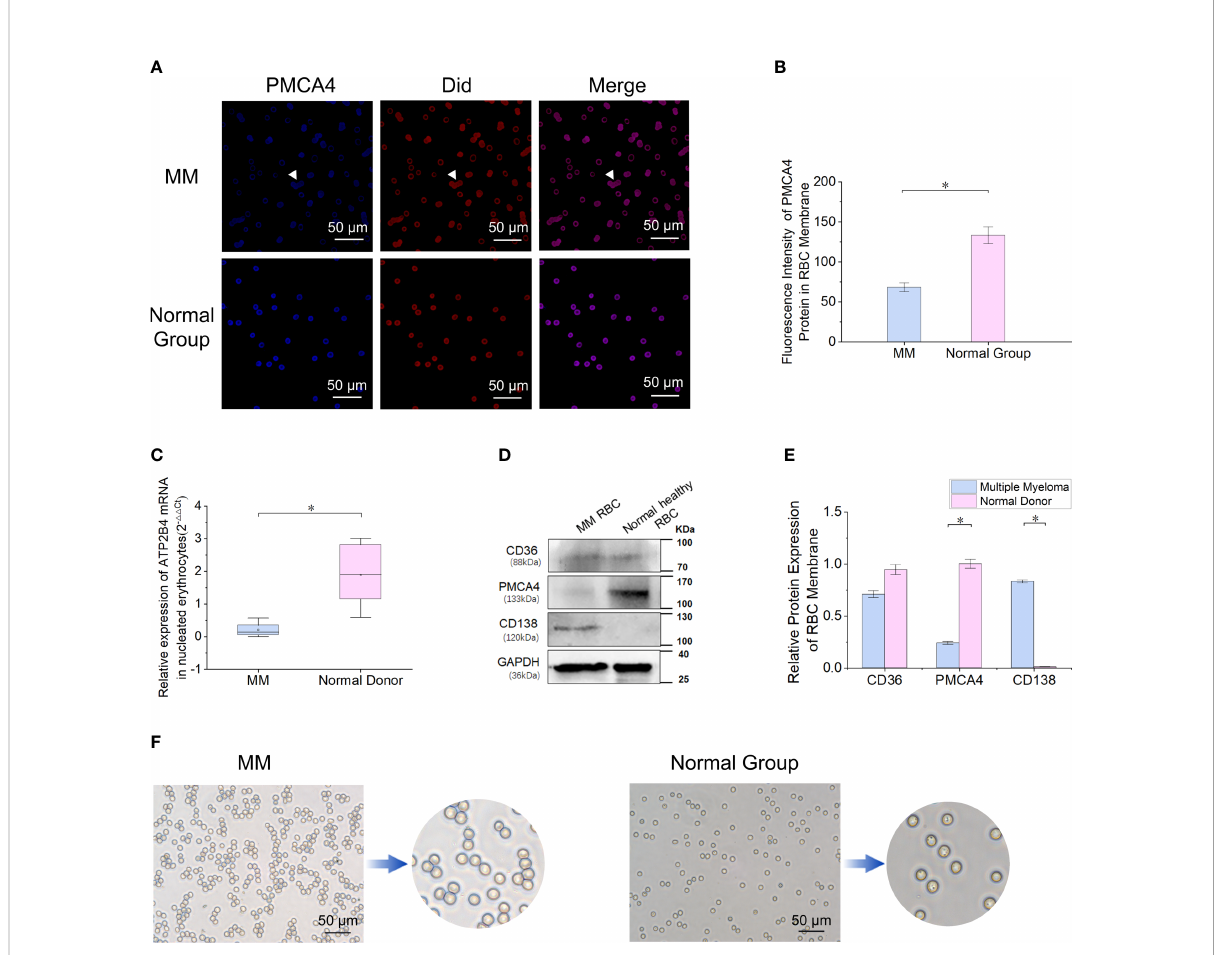
FIGURE 2 Reduced expression of PMCA4 in RBCs of MM. (A, B) Indirect cellular immuno fl uorescence labeling of the surface of RBCs with PMCA4 (blue), RBC membrane with Did labeling (red), PMCA4 expression in MM RBCs is signi fi cantly reduced ( P = 5.1E-03). The white arrow indicates the stacking of RBCs (rouleaux formation) in MM (magni fi cation, 60×). (C) Relative mRNA expression of ATPase plasma membrane Ca 2+ transport 4 (ATP2B4) in nucleated RBCs of MM bone marrow is signi fi cantly lower than that in the normal control group (GAPDH was used as an internal control) ( P = 5.1E-03). (D, E) The expression of PMCA4 in MM RBCs was signi fi cantly reduced ( P = 5.1E-03), and CD138 was expressed. (F) After the antibody-labeled RBCs reacted with the substrate BCIP/NBT, the dark blue NBT-formazan deposits in the erythrocyte membrane of MM reacting with PMCA4 protein content were signi fi cantly lower than those of the normal control group. (Error bars represent the mean ± SEM, *P <